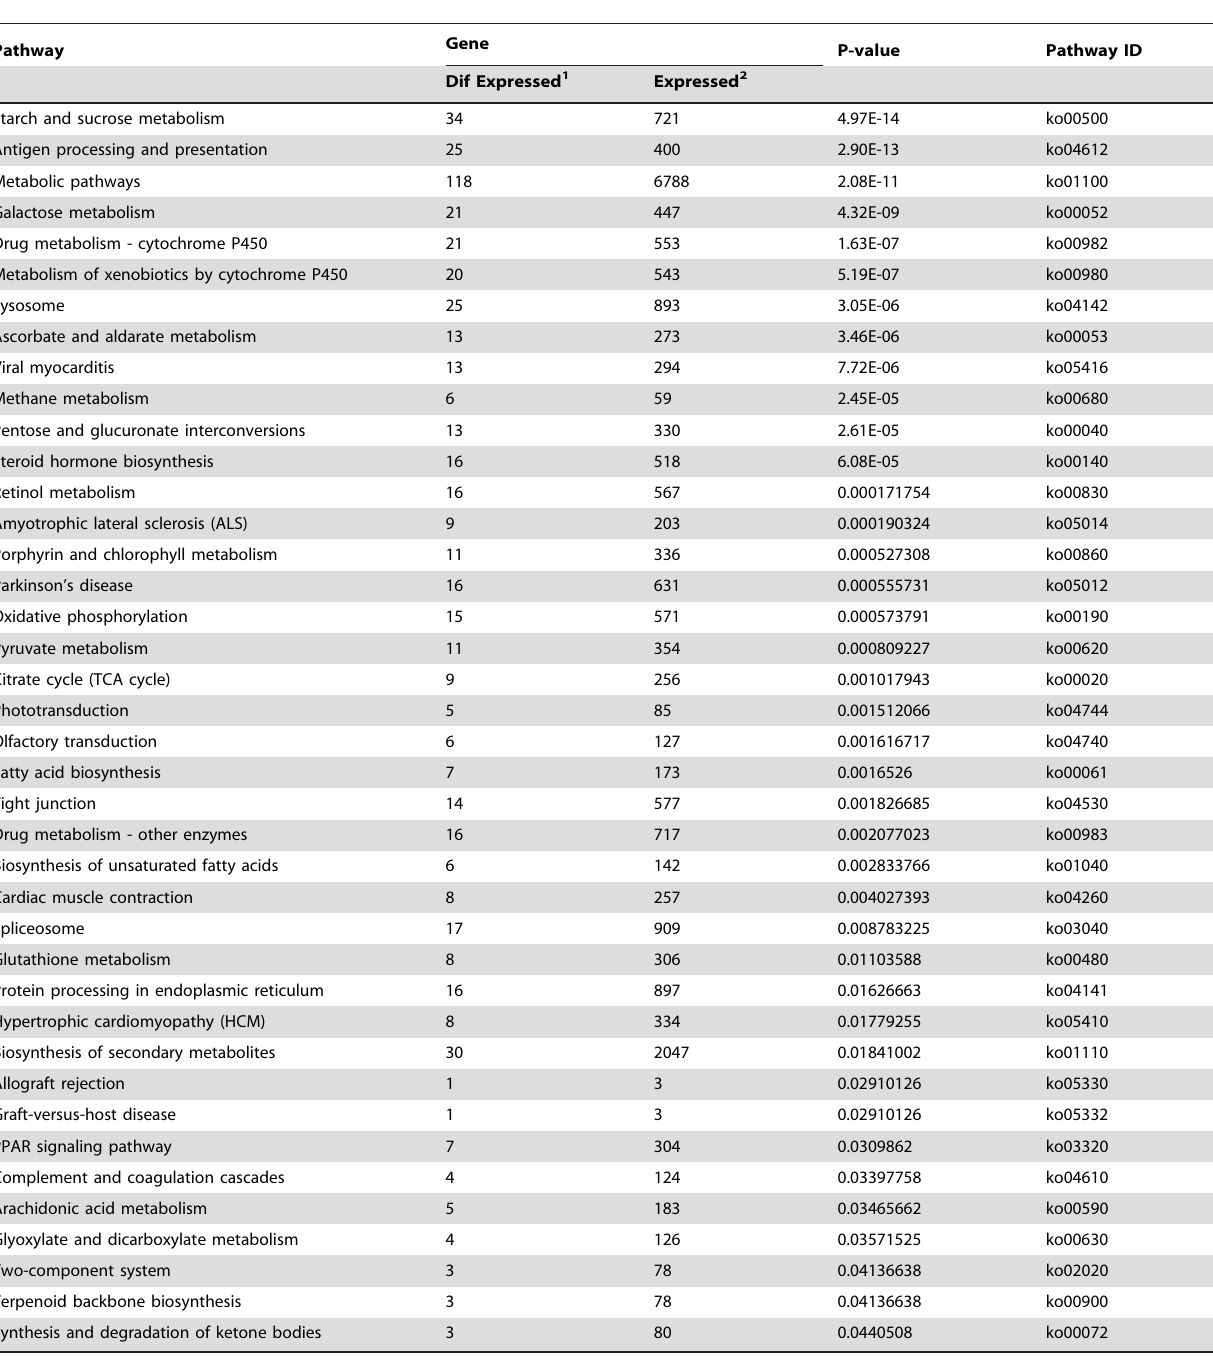
Table 3. Significantly enriched KEGG pathways in B. tabaci